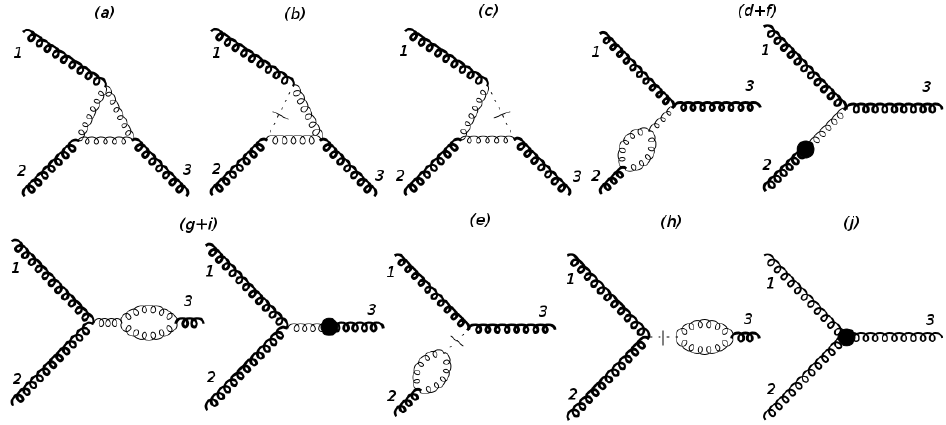
Figure 1. Third-order contributions to the running coupling, including the counterterm. Terms ( a )-( i ) correspond to γ ( a ) − γ ( i ) of Eq. (29), term ( j ) is the third-order counterterm corresponding to γ ( j ). External e ff ective particles are labeled 1, 2 and 3 and are represented with bold gluonic lines.